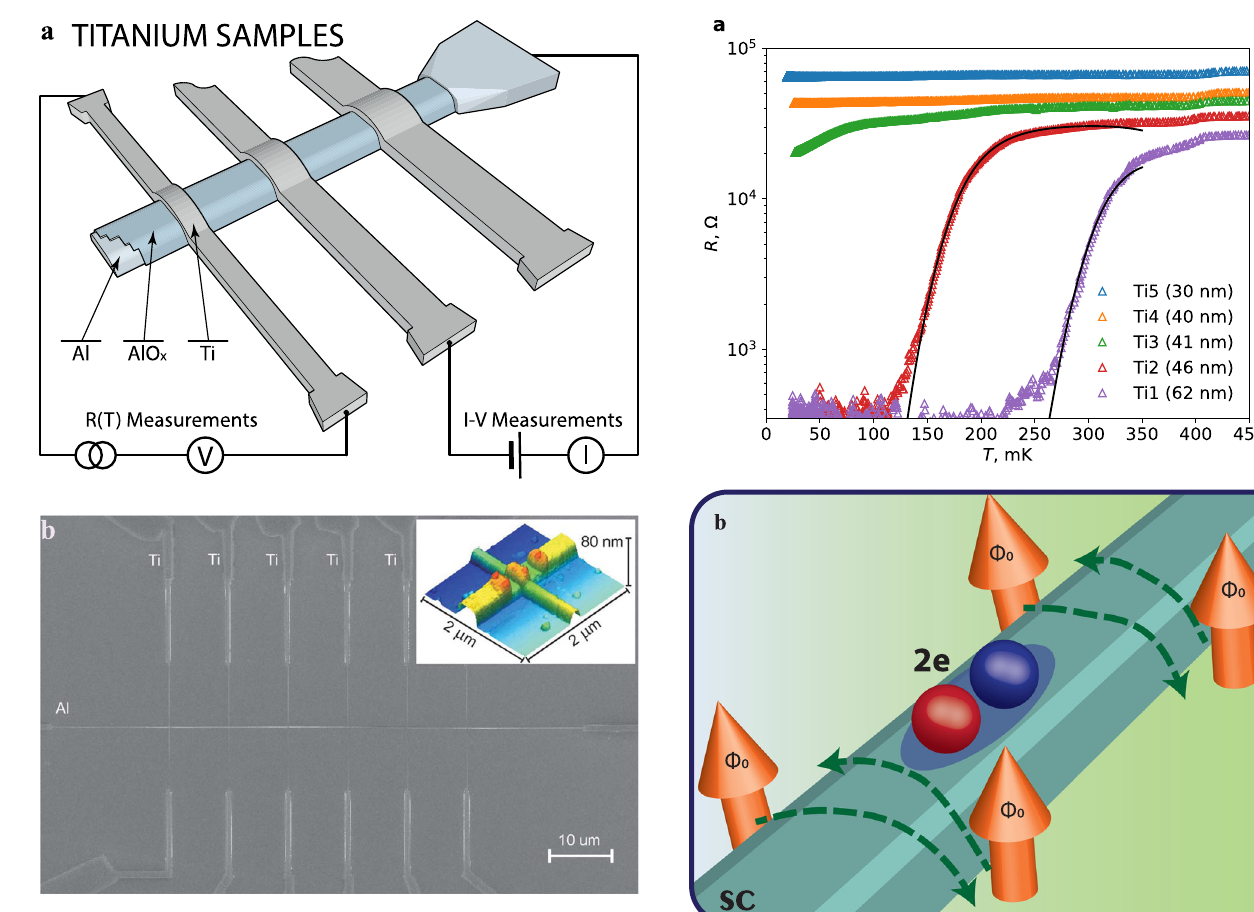
Fig. 2 Schematics of experiment and sample layout. a Long and thin titanium nanowires having the form of narrow strips overlap a relatively wide aluminum electrode through a tunnel barrier (aluminum oxide). The structure enables one to carry out both pseudo-four-terminal measurements of the total resistance for all nanowires and local measurements of the current – voltage characteristics for all Al – AlO x – Ti tunnel junctions. b Scanning electron microscope image of our typical structure. Inset: Zoom of the junction region taken with atomic force microscope. Fake color corresponds to variation of the sample height from 0 (substrate, dark blue) to 80 nm (overlapping titanium, orange).